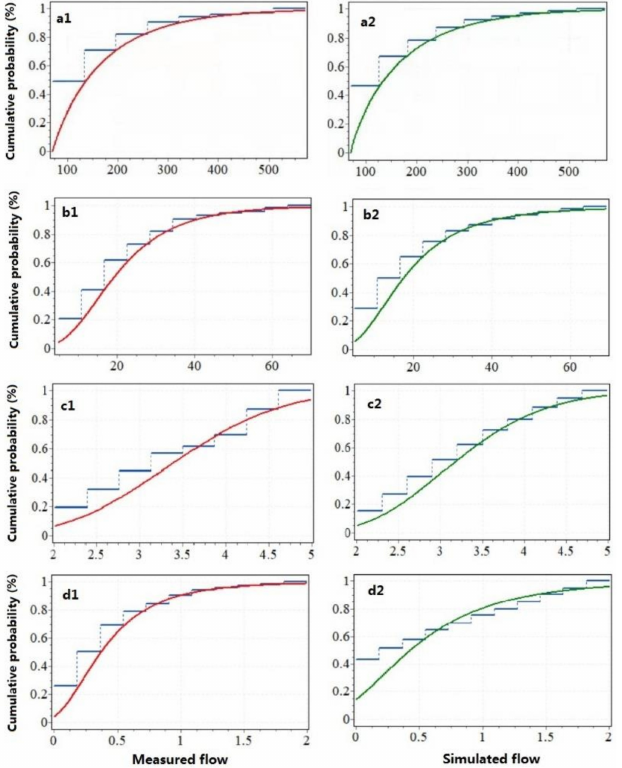
Figure 8. Occurrence probability diagram of measured and simulated daily runoff at different water levels ( a1 , a2 ) ≥ 70, 5 ≤ ( b1 , b2 ) < 70, 2 ≤ ( c1 , c2 ) < 5, ( d1 , d2 ) <